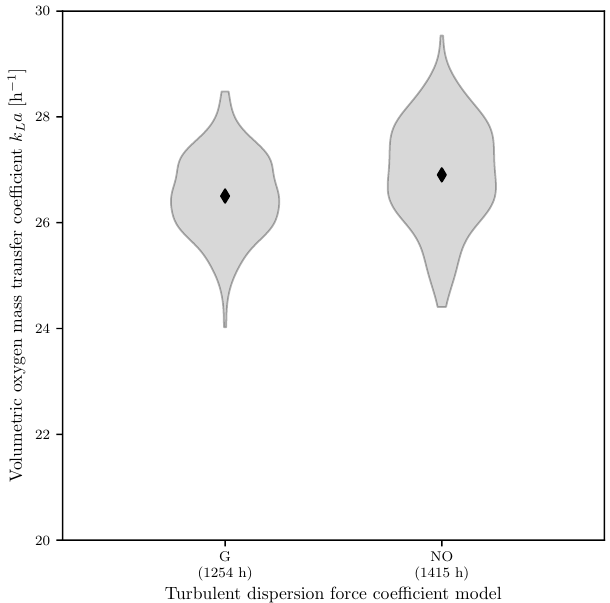
Figure 8. Influence of the turbulent dispersion force coefficient model on the k L a value. The mean values and the corresponding probability density function are shown in violin form. The time corresponds to the CPU time required for the simulation of 20 s (G = Gosman [64], NO = no turbulent dispersion